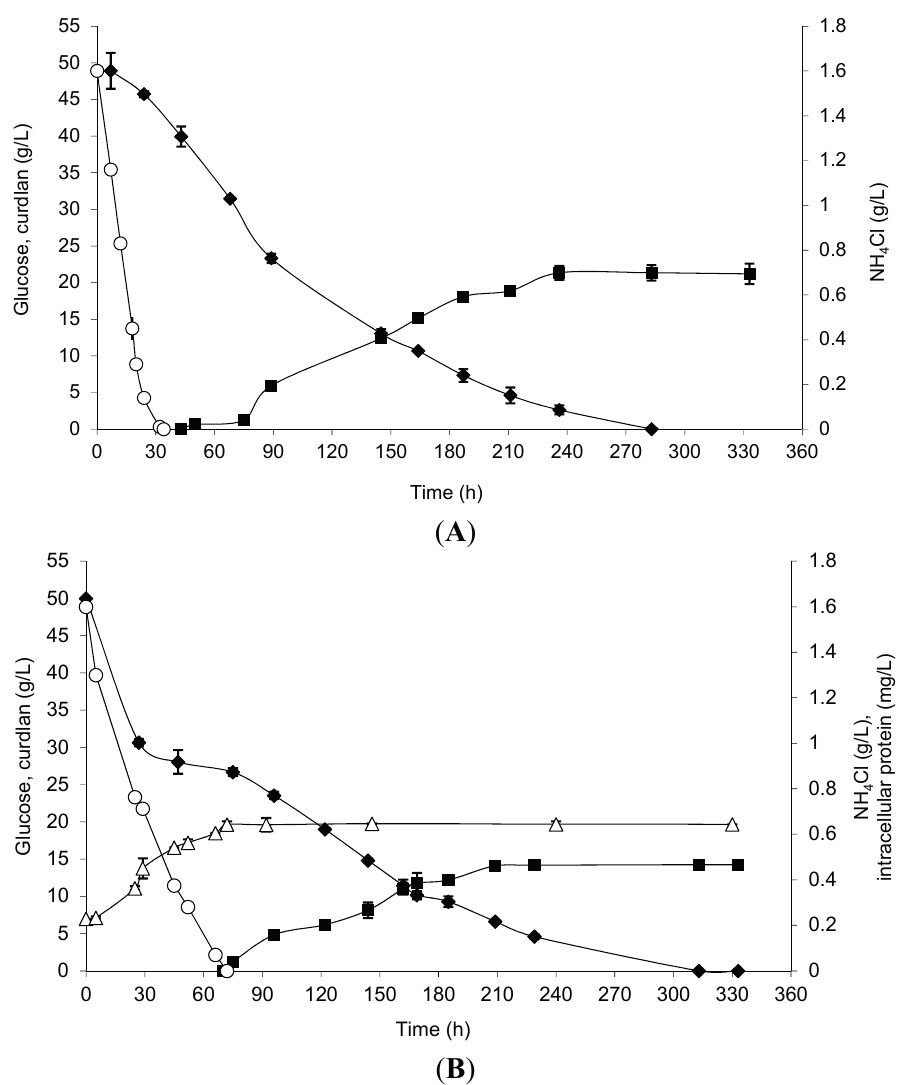
Figure 3. Curdlan production (closed squares), biomass represented by intracellular protein (open triangles), glucose consumption (closed diamonds) and NH 4 Cl (open circles) by Agrobacterium sp. IFO 13140 immobilized on loofa sponge ( A ) and free cells ( B ) at 30 °C and 150 rpm for 14 days of incubation. The immobilization conditions used were 72 h of incubation, 50 mg of cells and a shaking rate of 200 rpm. The error bars represent standard deviations of